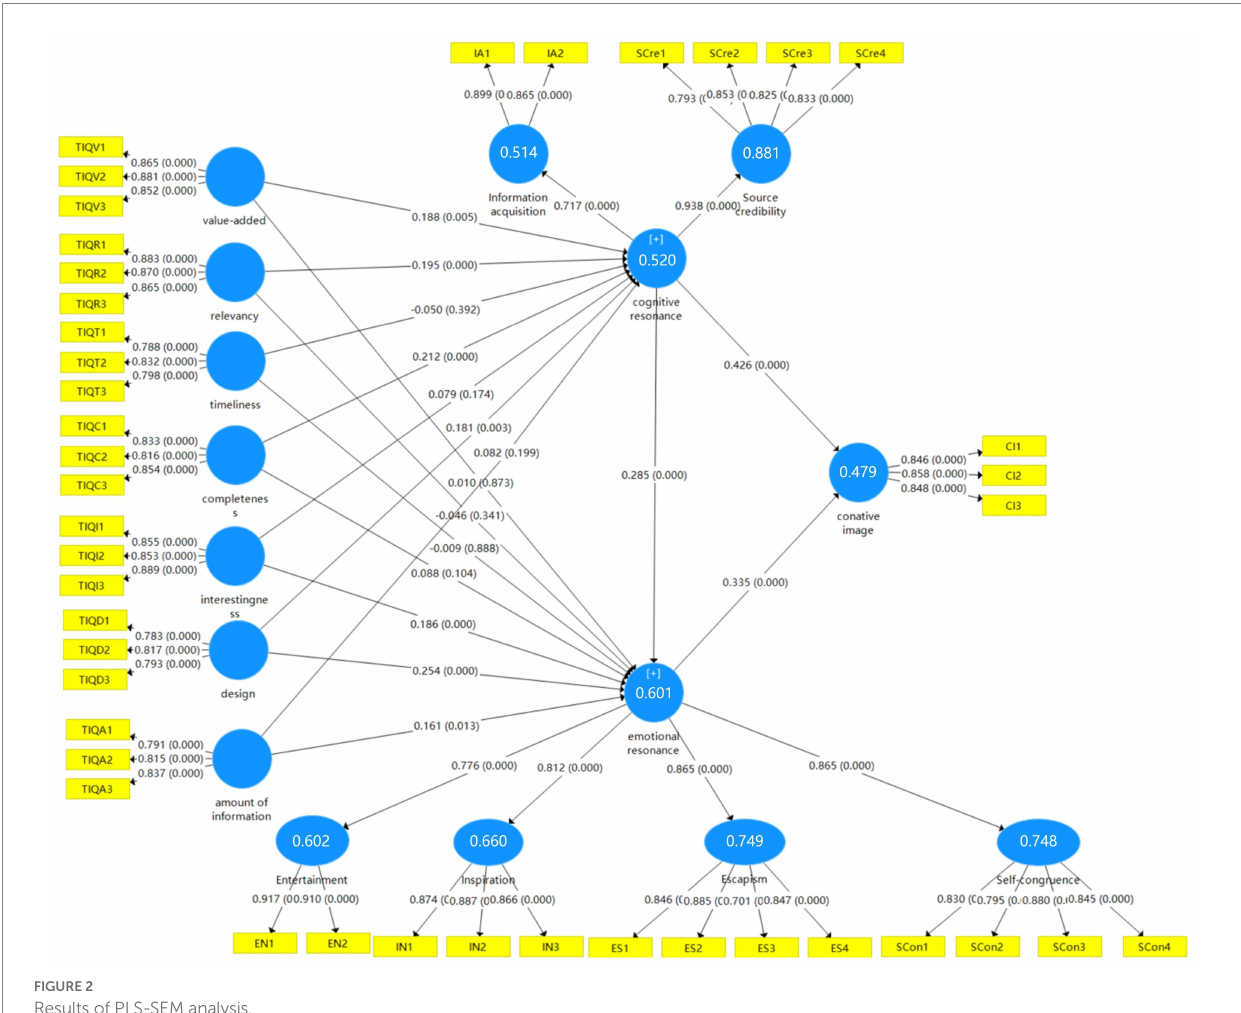
FIGURE 2 Results of PLS-SEM